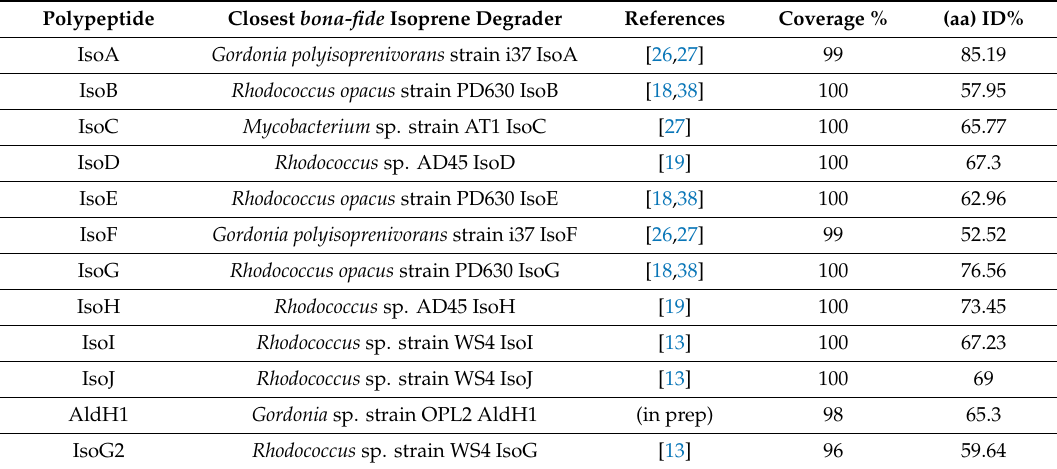
Table 2. Blastp comparison of polypeptides encoded by isoprene degradation genes in Nocardioides sp. WS12 to those from isoprene degrading